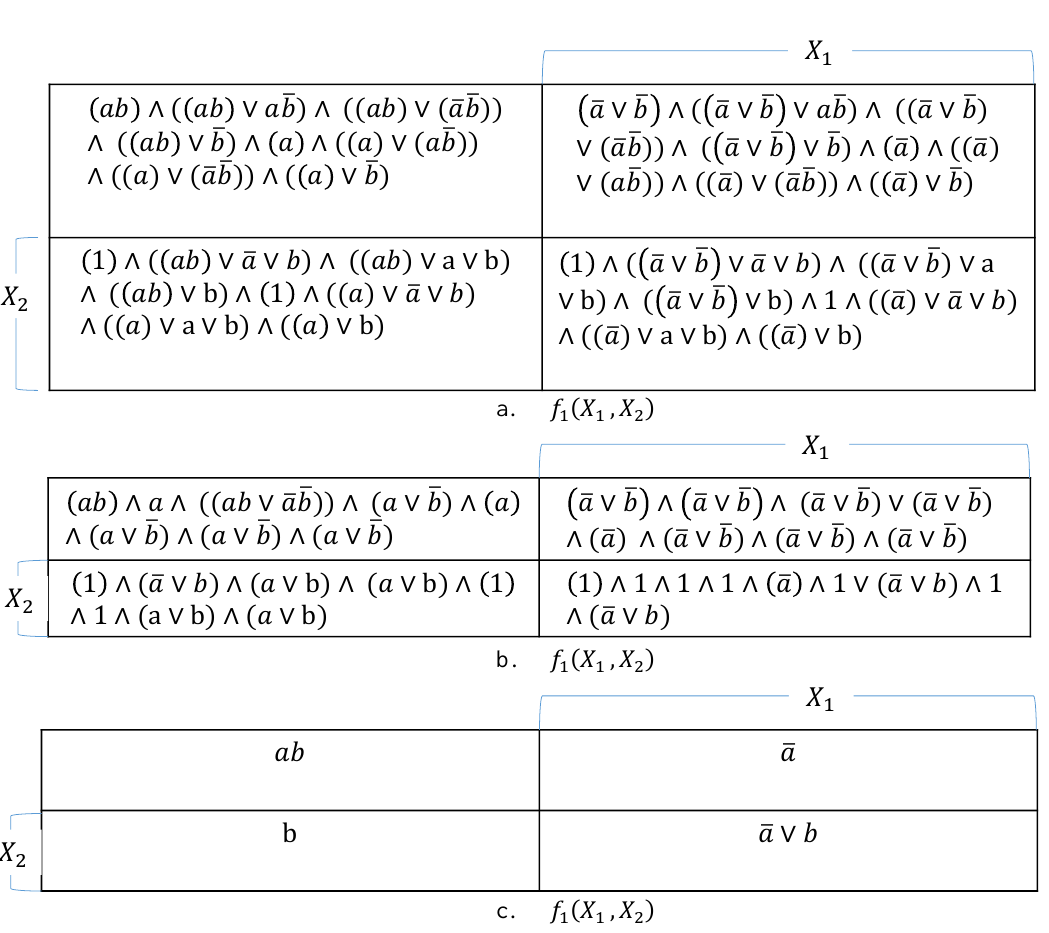
Fig. 3. Three consecutive instances of the natural maps (VEKMs) of 𝑓